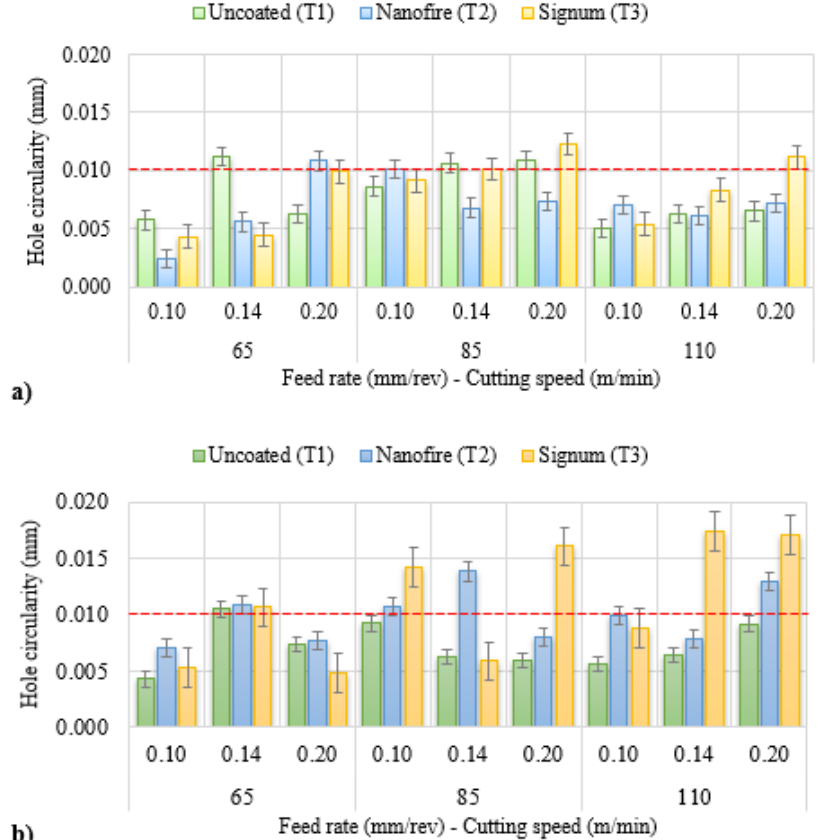
Figure 6. Effect of machining parameters on circularity error: a) Hole top surface (HT), b) Hole bottom surface